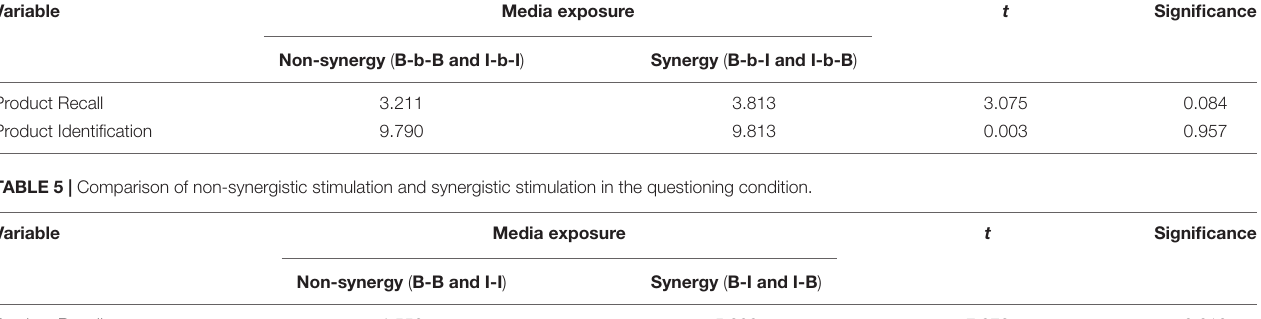
TABLE 4 | Comparison of non-synergistic stimulation and synergistic stimulation in the interference condition. Variable